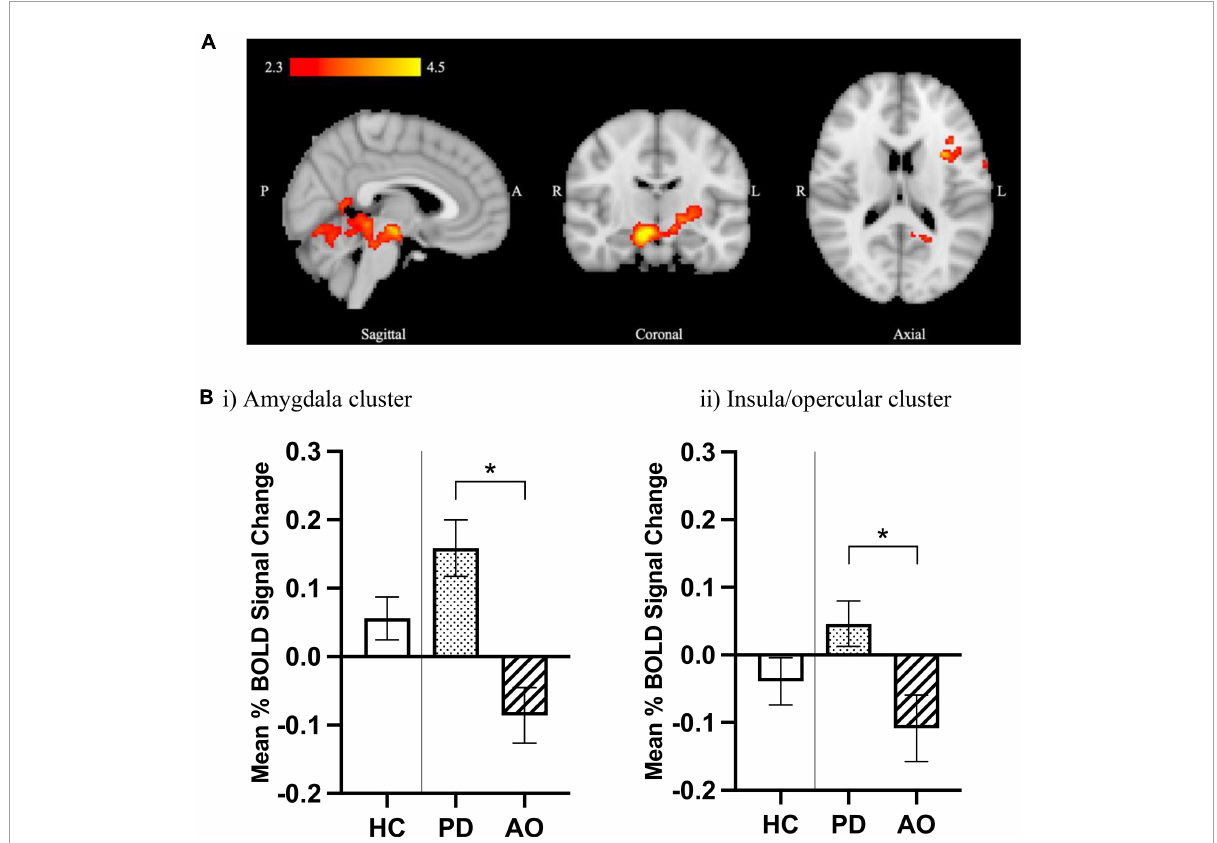
FIGURE2 Increased limbic BOLD response to aversive processing in PD relative to AO groups under placebo. (A) Increased BOLD signal in the PD > AO group for the aversive > neutral contrast. Color bar shows z -stat values from an unpaired t -test using FSL FLAME-1, mixed-effects analysis ( Z > 2.3, p < 0.05), controlling for center and age. MNI coordinates: x = 3.6, y = –13.7, z = 16.9. (B) Mean% BOLD signal change from extracted significant clusters in (i) cluster 1 including amygdala, putamen, hippocampus, left thalamus, cingulate gyrus, and pallidum and (ii) cluster 2 including left insula, left precentral gyrus, left postcentral gyrus, left central opercular cortex, and left inferior frontal gyrus (pars opercularis). Data are mean ± SEM for PD ( n = 17) and AO ( n = 19) groups, plotted next to HCs ( n = 32) for visual reference. *Indicates significant difference as determined by whole brain analysis in (A) .